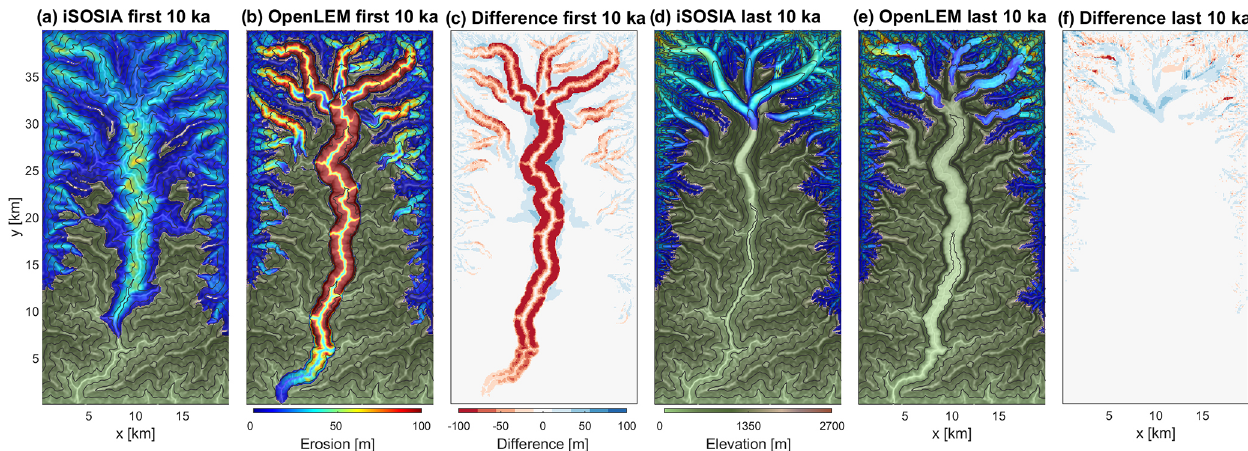
Figure 8. Model-dependent evolution of erosion patterns. Glacial erosion computed by (a) OpenLEM and (b) iSOSIA and (c) differences in erosion between the two models over the first 10ka of glacial occupation. Panels (d) , (e) and (f) show the same properties but for the time slice between 90 and 100ka. Contour spacing for surface elevation is 200m.